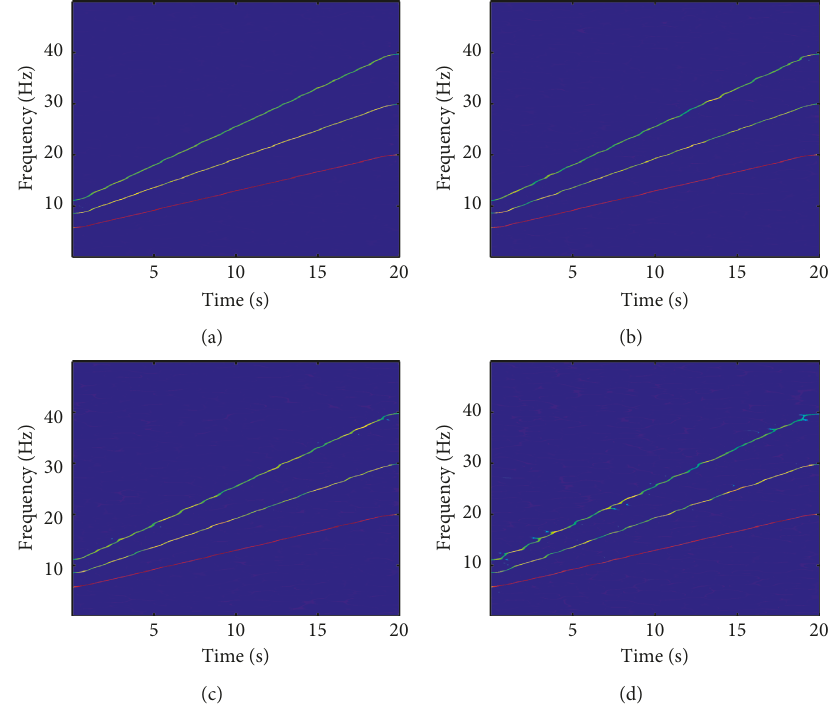
Figure 13: VMD-SET time-frequency representation of LFM signal under different SNR: (a) 10dB, (b) 0dB, (c) − 10dB, and (d) − 20dB.